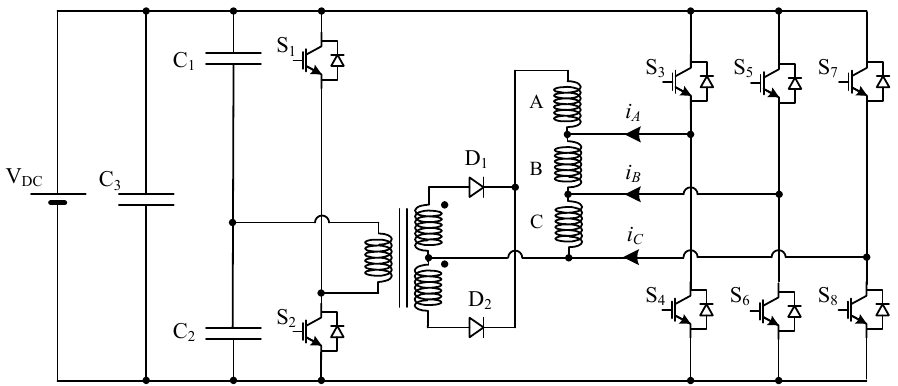
Figure 6. Conventional three-phase bridge topology .